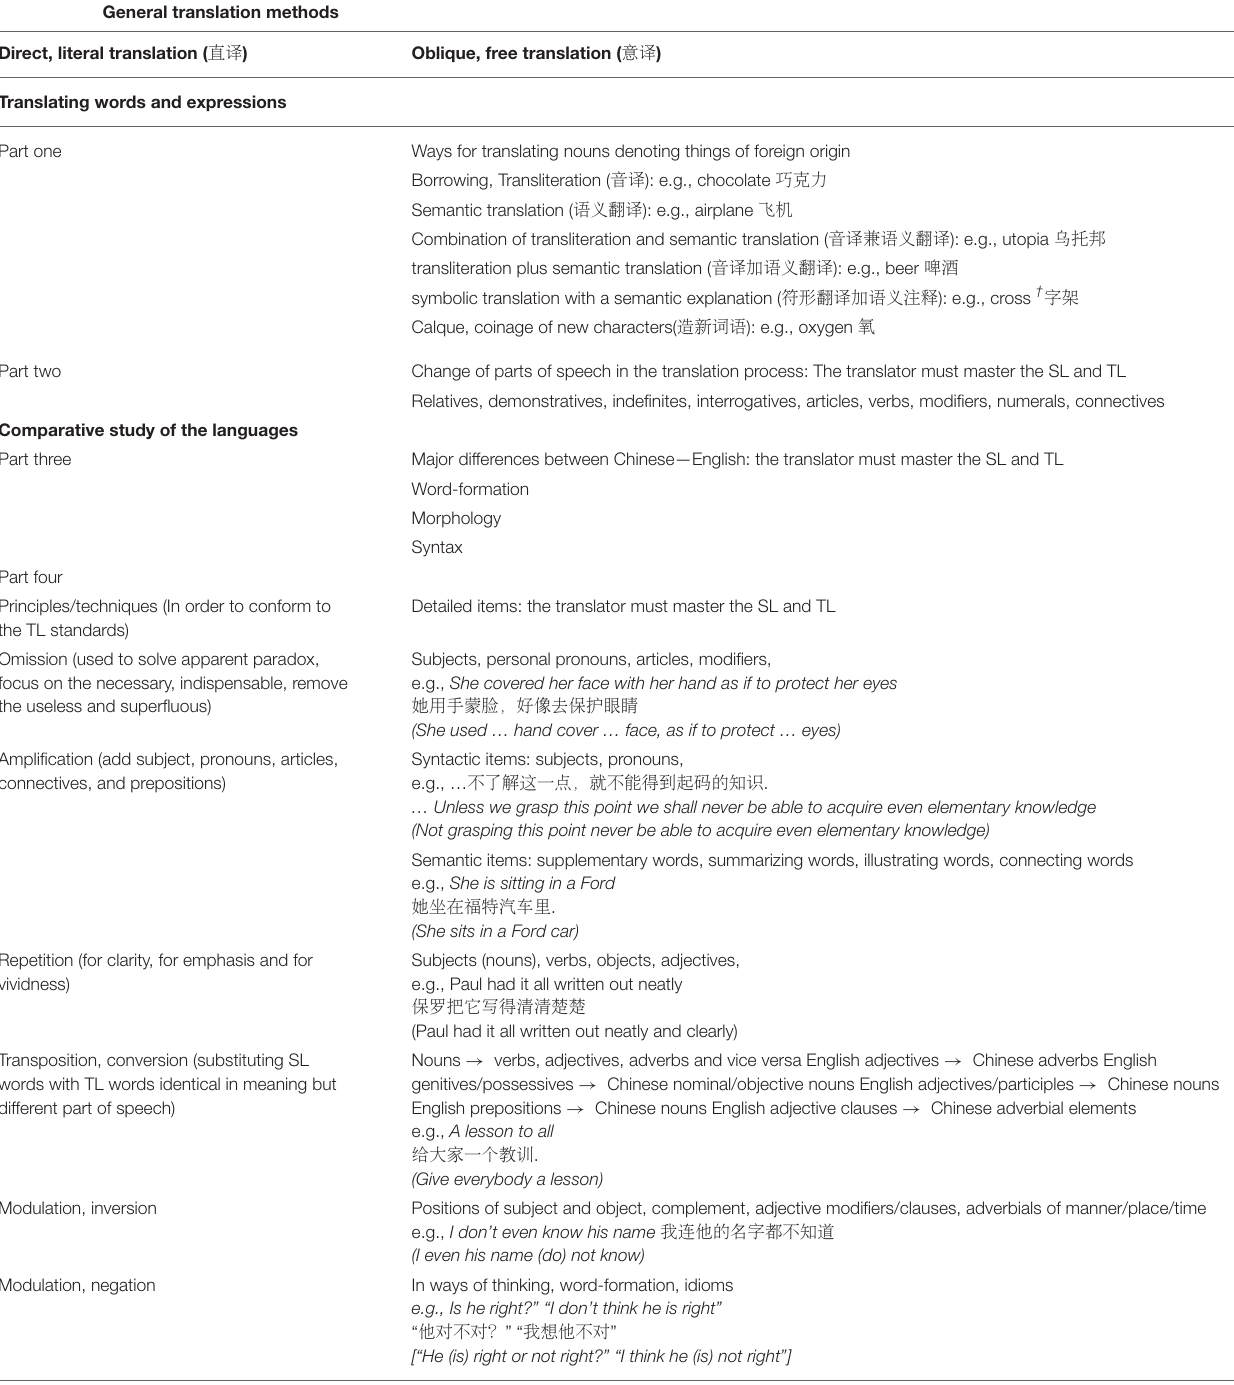
TABLE 1 | Model of translation principles and techniques. General translation